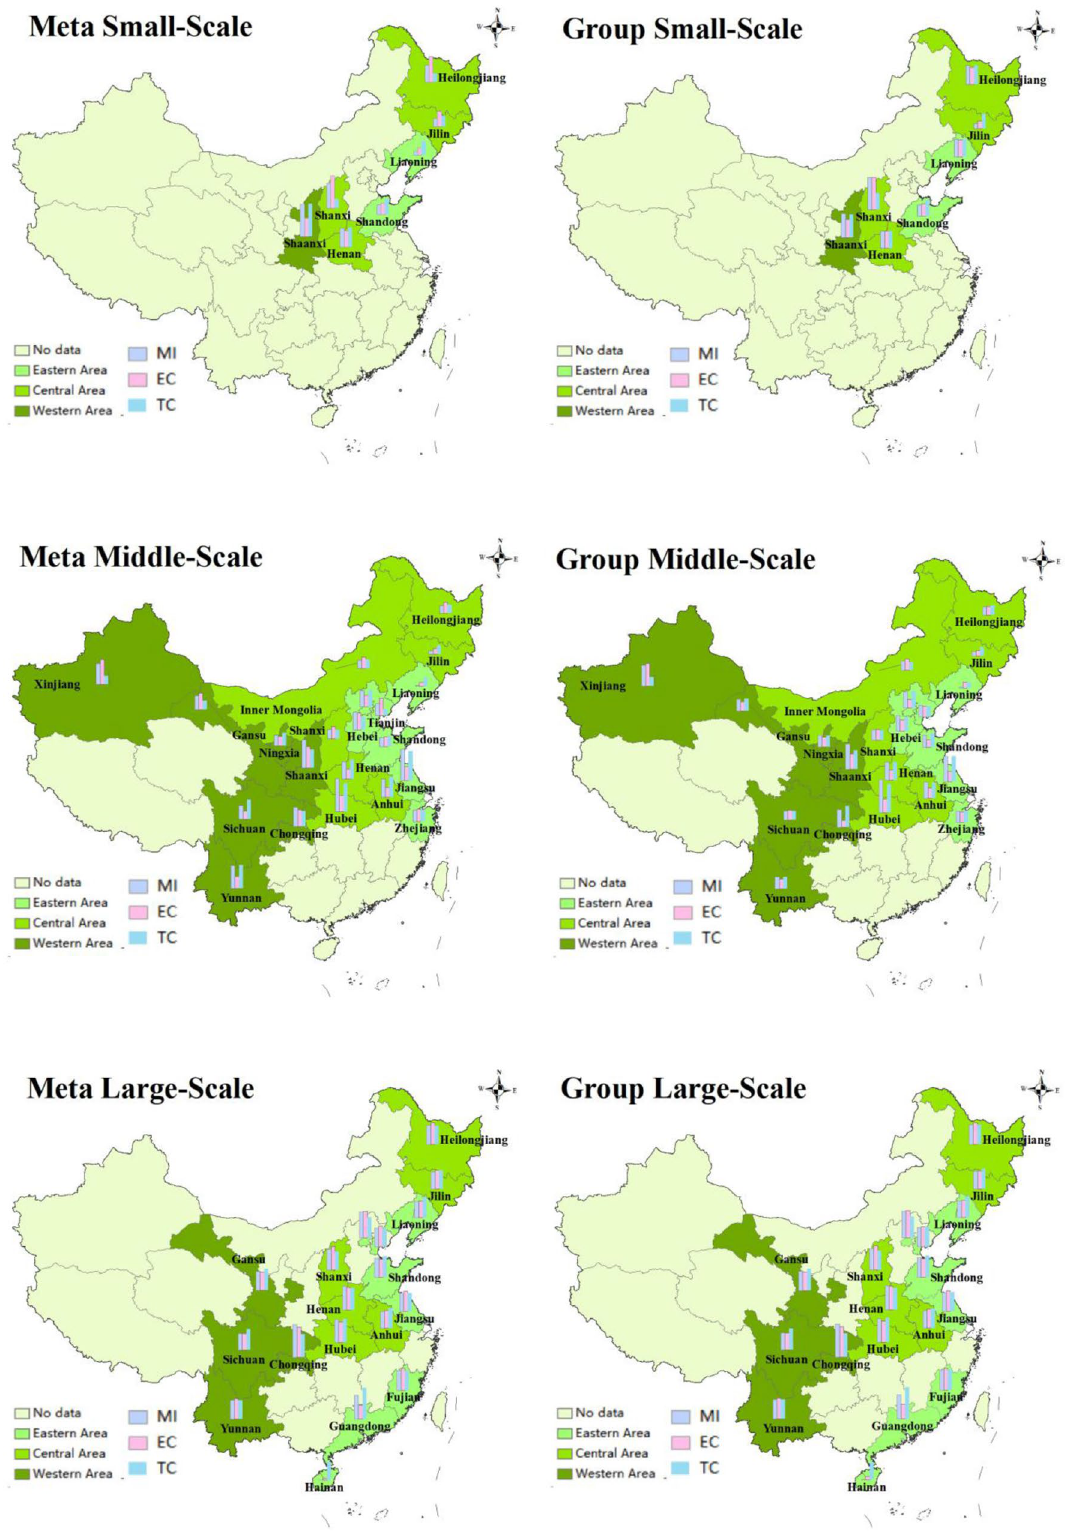
Figure 6. Three-sized average LHG and its decomposition index in different regions. Source ArcMap10.7 https:// deskt op. arcgis. com/ zh- cn/